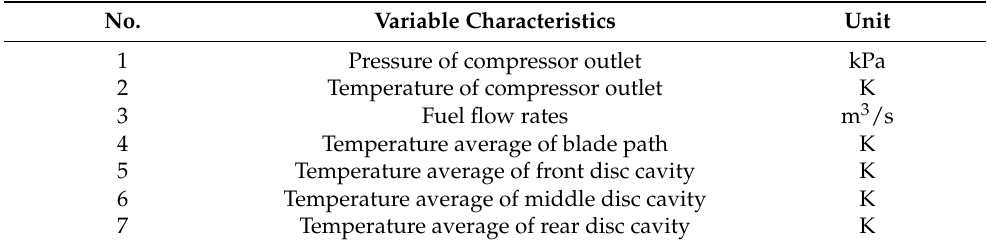
Table 2. Detailed explanation for seven tag data.